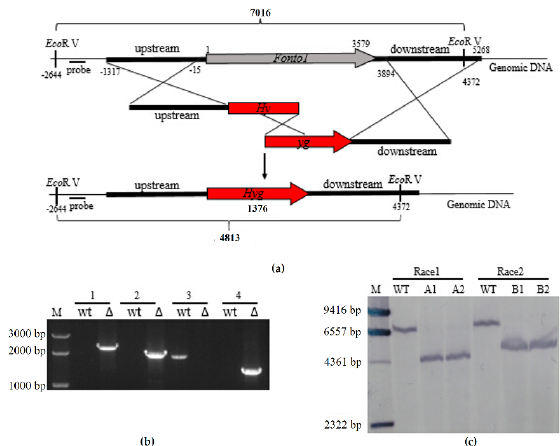
Figure 2. Deletion of Nto1 in F. oxysporum f. sp. conglutinans . ( a ) Schematic diagram of gene-disruption and Southern blot analysis verification strategy; ( b ) PCR strategy to screen Δ Nto1 transformants. M: marker; wt: wild type; Δ : Nto1-deleted mutant. 1 = PCR performed with primer pair CupF/CupR; a 2.3-kb amplified fragment indicates Δ Nto1 integration at the left junction. 2 = PCR performed with primer pair CdpF/CdpR; a 2.2-kb amplified fragment indicates Δ Nto1 integration at the right junction. 3 = PCR performed with primer pair PeF/PeR; the result indicates that Nto1 was deleted. 4 = PCR performed with primer pair HL/HR; a 1.4-kb amplified fragment indicates that Hyg was inserted to the F. oxysporum f. sp. conglutinans genome; ( c ) Southern blot analysis confirms the gene deletion mutants. The genetically stable gene deletion transformants of FOC wild type strains race 1 were named 1- Δ Fonto1-1 and 1- Δ Fonto1-2. The mutants of race 2 were named 2- Δ Fonto1-1 and 2- Δ Fonto1-2. M: Marker; WT: wild type; A1: 1- Δ Fonto1-1; A2: 1- Δ Fonto1-2; B1: 2- Δ Fonto1-1; B2: 2- Δ Fonto1-2.